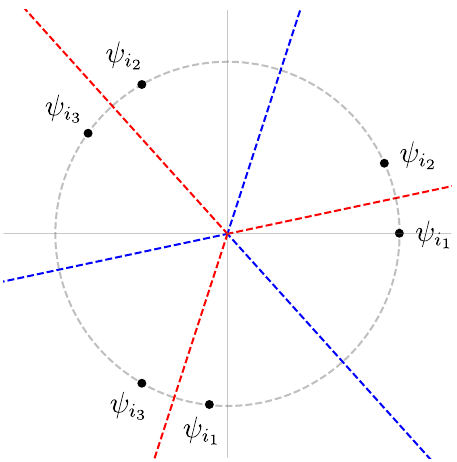
Figure 7 . The uniformized plane for n = 3 , x = 0 . 2 . Branch cuts from the Σ 3 ( C x ) manifold are shown as dashed blue lines, and branch cuts from Σ 3 ( C x ) are shown as dashed red lines. These cuts are the uniformized images of the cuts appearing in figure 2. Notice that the blue cut images separate operators of the same type, and the red cut images separate operators of different type. This allows for an equivalence between the branched sphere correlators for the two patterns of operator insertions and